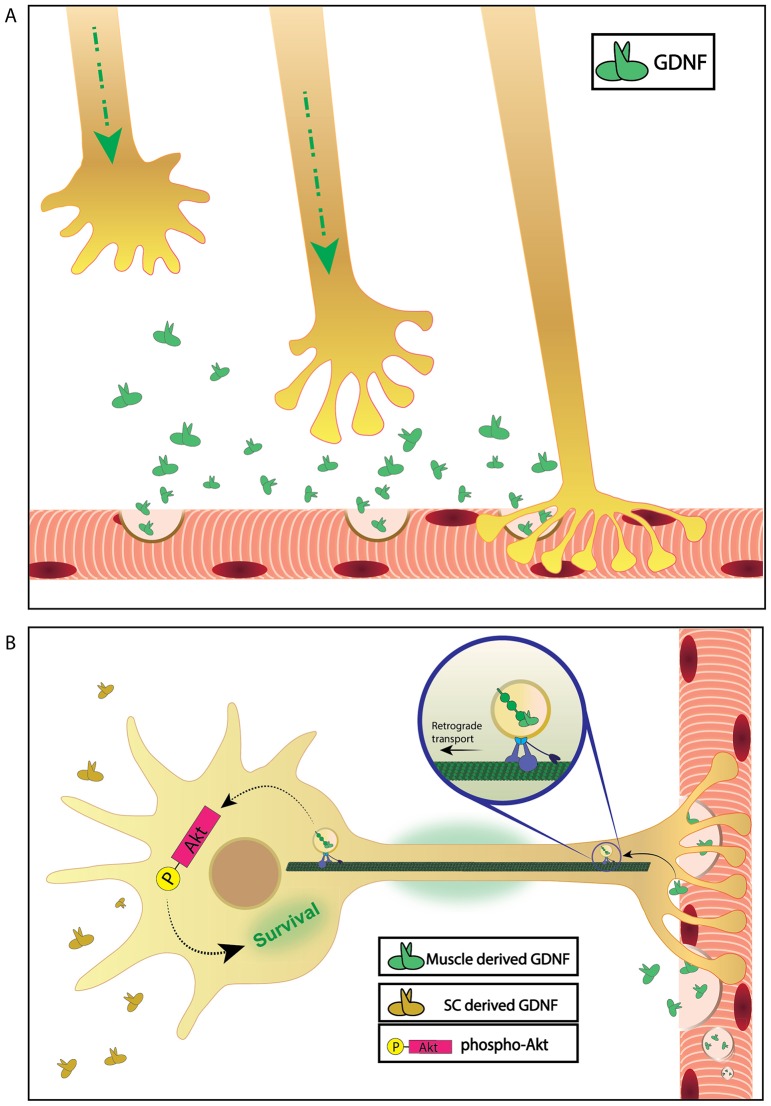
Model depicting the dual function of GDNF in motoneurons in promoting local axonal growth and innervation and long-distance survival signaling. (A) Local effect of GDNF on axonal growth, guidance and NMJ formation. (B) Long-distance effect of retrograde-transported GDNF in activating pro-survival signals in the cell body.